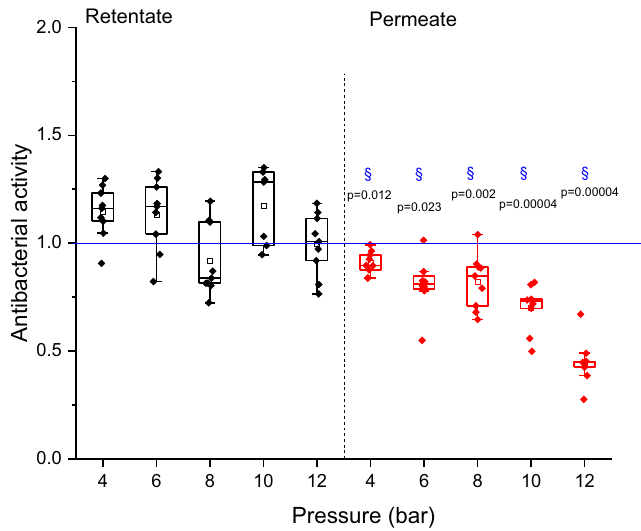
Figure 5. Lysozyme antibacterial activity for retentate (black) and permeate (red) solutions for lower cut-off membrane M3; § represents the significant difference for P < 0.05 with respect to lysozyme reference (untreated lysozyme), blue line represents the lysozyme